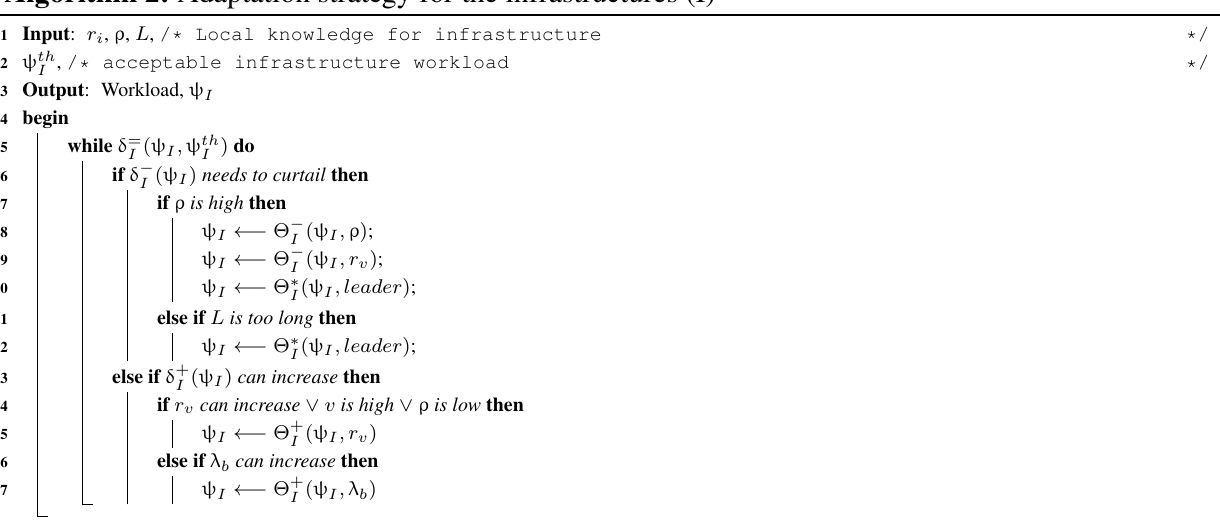
Algorithm 2: Adaptation strategy for the infrastructures (I)